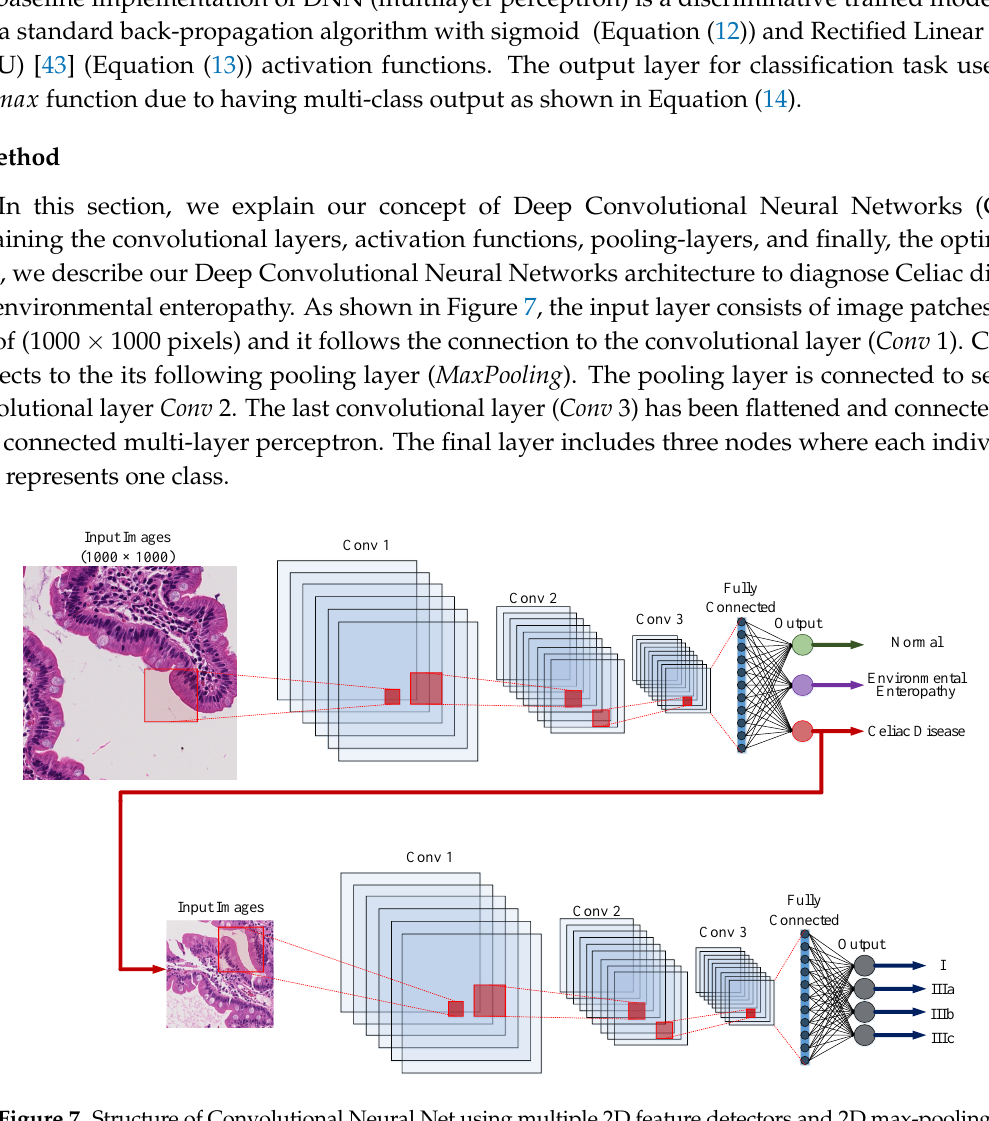
Figure 7. Structure of Convolutional Neural Net using multiple 2D feature detectors and 2D